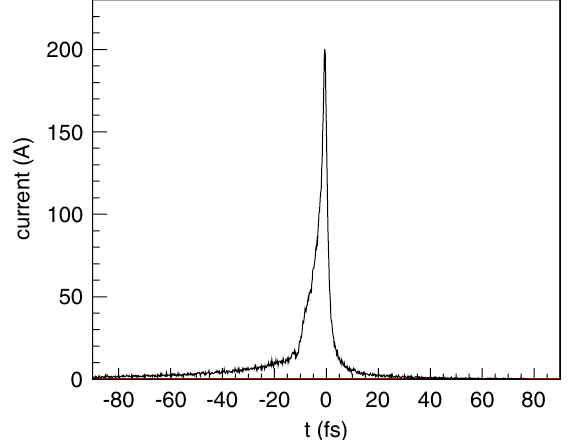
FIG. 6. Temporal distribution of a 1.6 pC beam at the sample. The peak current is 200 A and the FWHM bunch length is 4 fs. In a time duration of 10 fs around the peak, there is 55% of the bunch charge.